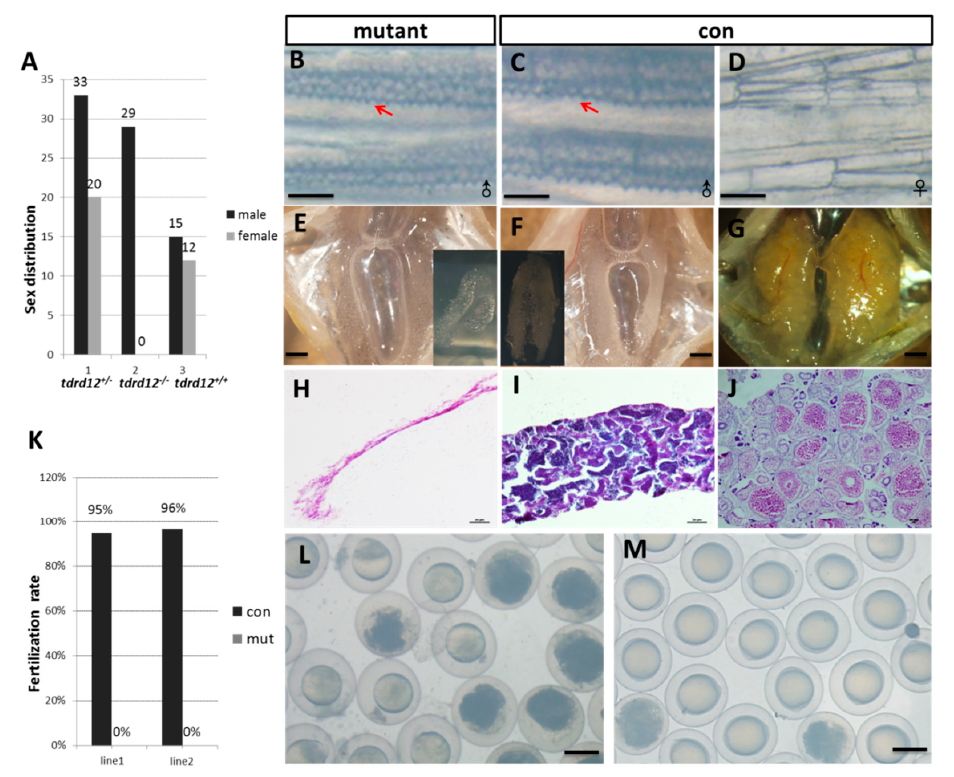
Figure 4. Tdrd12 deficiency results in masculinization and infertility in zebrafish. ( A ) Sex ratios of the progenies from the in-cross of tdrd12 heterozygous mutant fish (90 dpf). Among the progenies, all homozygous offspring developed into males. The total number of progenies for this analysis is 109. tdrd12 +/ − : heterozygous progenies; tdrd12 +/+ : wild-type progenies; tdrd12 − / − : homozygous progenies; ( B – D ) Appearance of the breeding tubercle (BT) clusters (red arrowheads) in the pectoral fin of all homozygous mutant fish ( B ) and wild-type males ( C ), but not in wild-type females ( D ), scale bar = 250 μ m; ( E – G ) Anatomical views of the gonadal tissues of the Tdrd12-deficient fish and wild-type adults. Only atrophied testes were observed in Tdrd12-deficient adults ( E ), while normal testes ( F ) and ovary ( G ) could be observed in wild-types adults, scale bar = 500 μ m; ( H – J ) Histological analyses of the gonadal tissues indicate no signs of germ cells in the atrophied testes of the Tdrd12-deficient adults ( H ), while normal spermatogenesis ( I ) and oogenesis ( J ) progresses in the wild-type adults, scale bar = 50 μ m; ( K ) The fertilization rates of the mating between wild-type ( tdrd12 +/+ ) males and Tdrd12-deficient fish with wild-type females at the 120-dpf stage were recorded. The average fertilization rates of the 10 fish from three separate experiments were measured. Each group consists of 10 pairs of fish. The data shown here represent the means ± standard error of the mean; and ( L , M ) Morphological observations of embryonic development at 11 hpf derived from the mating between wild-type females with Tdrd12-deficient adults ( L ) and wild-type males ( M ); eggs from wild-type females could be induced by Tdrd12-deficient fish, but no successful fertilization could be found, scale bar = 250 μ m.